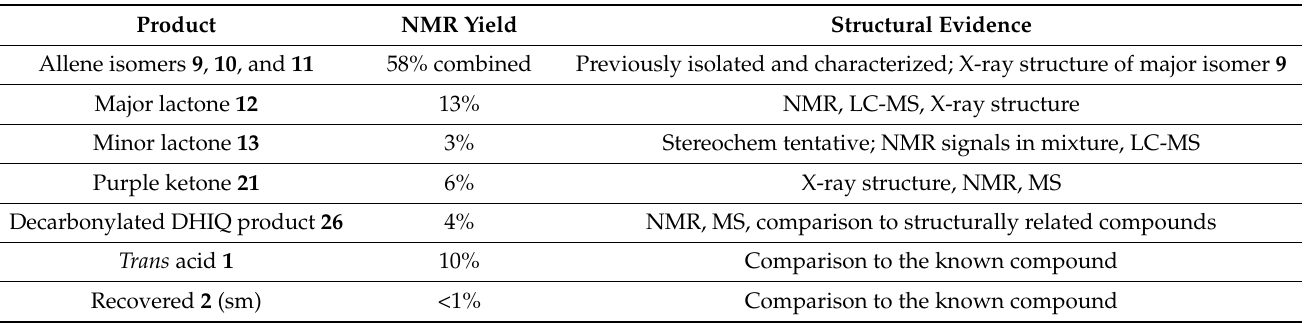
Table 1. Products from the reaction of cis THIQ carboxylic acid 4 with T3P. NMR yields are based on H-1 NMR analysis with cis -stilbene as the internal integration